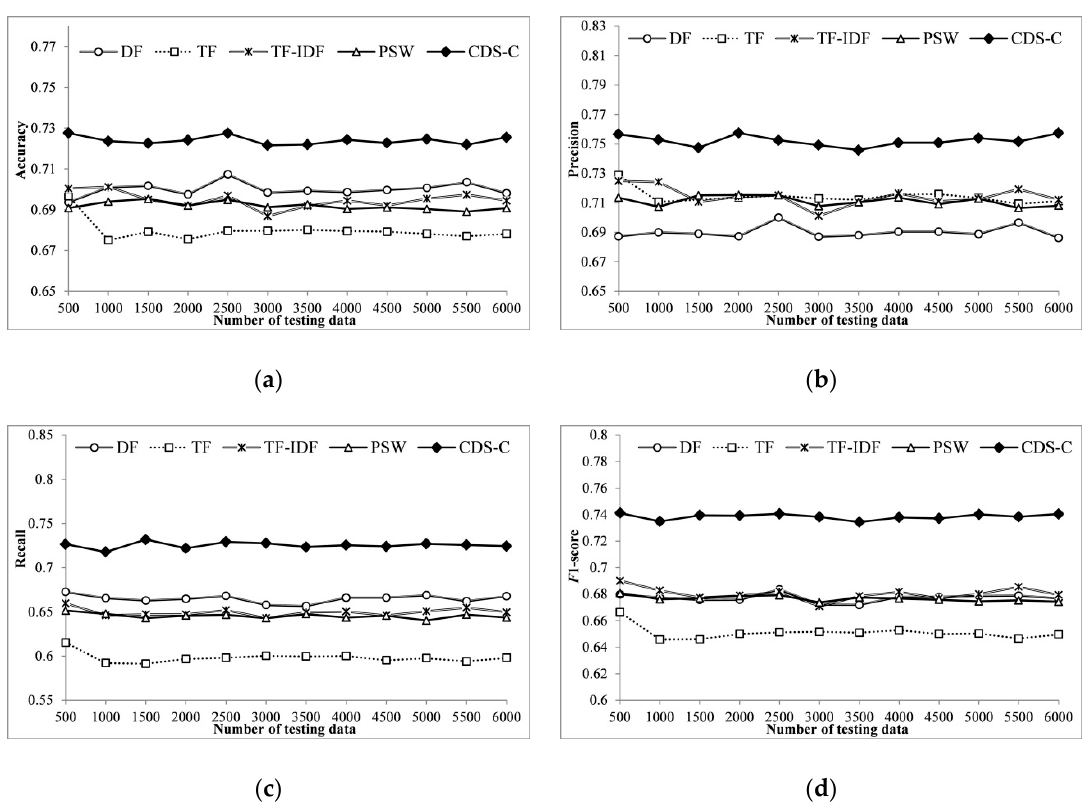
Figure 6. The comparisons of the schemes with randomly formed dataset. ( a ) Accuracy; ( b ) precision; ( c ) recall; ( d ) F1-score.